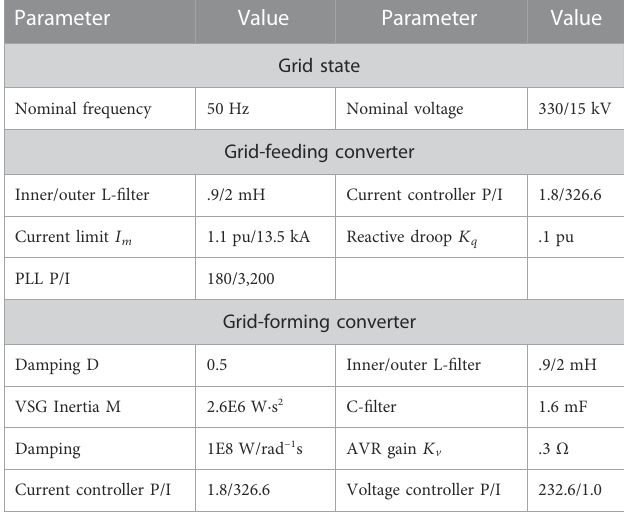
TABLE 1 Testing system